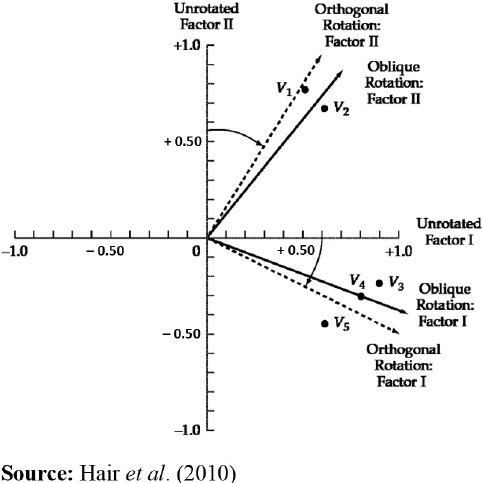
Figure 2. Comparison between orthogonal and oblique